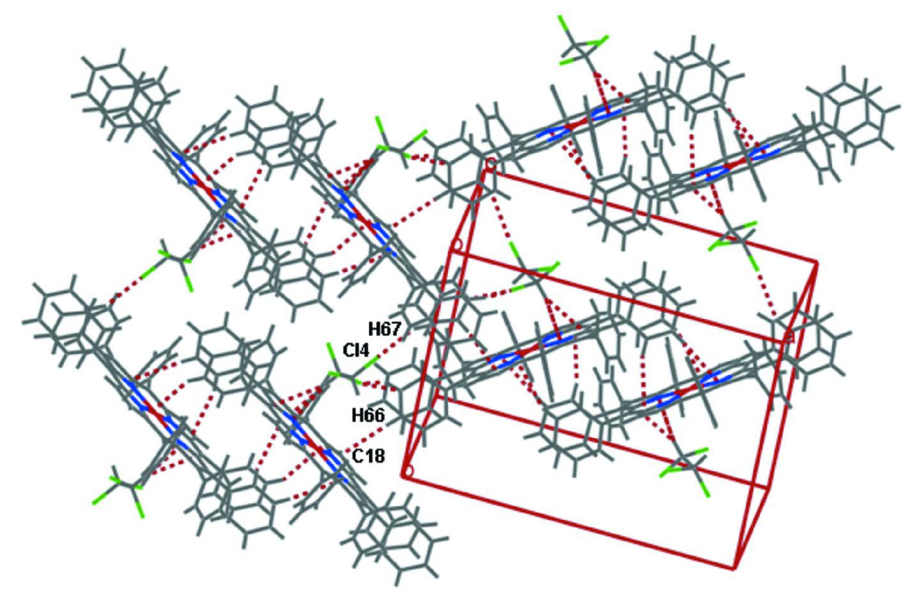
Figure 3 View of the molecular packing of interconnecting two arrays to form a two-dimensional network of the title structure. Color scheme: C, H, gray; N, blue; Cl, green; Cu, red. The dotted red lines show the inter-array hydrogen bonding C— H···Cl (H67···Cl4) and C—H··· π (H66···C18)